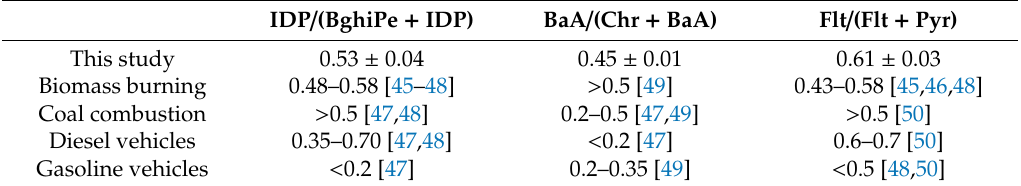
Table 4. Diagnostic ratios of PAH isomers from di ff erent emission sources and atmospheric